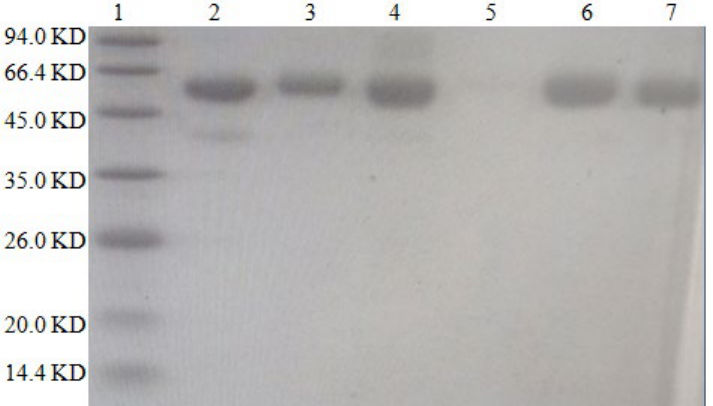
Figure 3. The SDS – PAGE characteristic of four artificial antigens for DON- BSA . 1 — Maker; 2 — BSA; Figure 3. The SDS–PAGE characteristic of four artificial antigens for DON-BSA. 1—Maker; 2—BSA; 3 —DON- BSA (CDI); 4 —DON- BSA (EDC); 5 — Blank; 6 —DON- BSA (IBCF); 7 —DON- BSA (NHS). 3—DON-BSA (CDI); 4—DON-BSA (EDC); 5—Blank; 6—DON-BSA (IBCF); 7—DON-BSA (NHS).